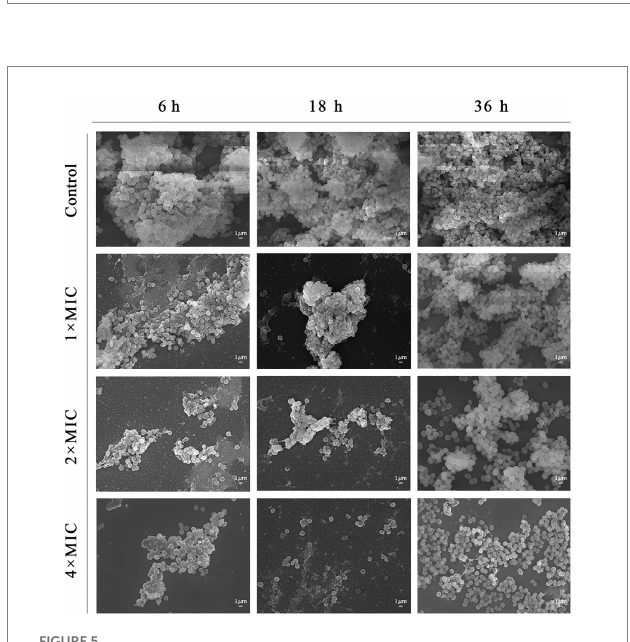
FIGURE 5 SEM images showing the effects of Disaspidin BB on SEP-05. Magnification: ×5,000.